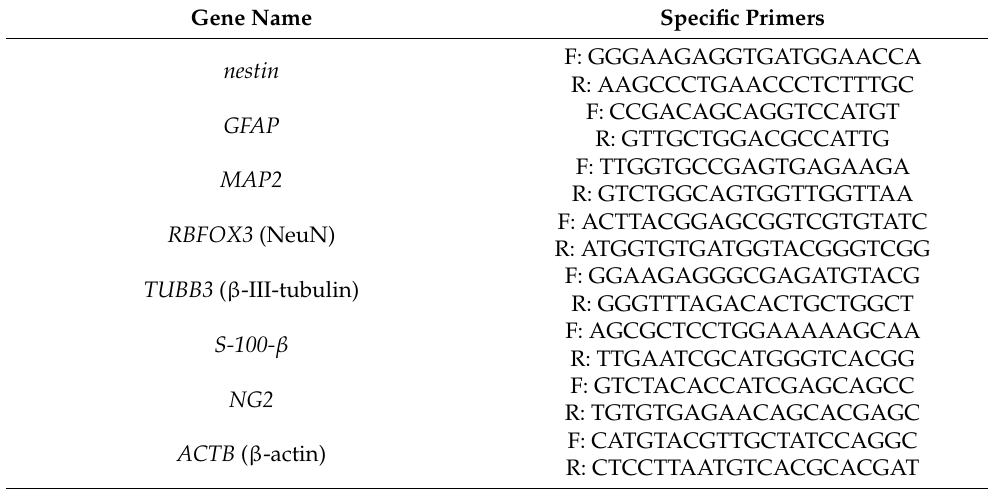
Table 1. List of primers used for real-time quantitative polymerase chain reaction (RT-qPCR).